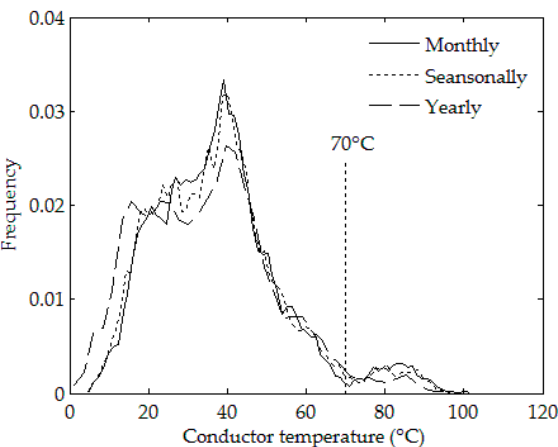
Figure 8. Conductor temperature frequency distribution of QDR under different time scales (99% confidence level). Table 4. Rating results analysis under 99% confidence level.